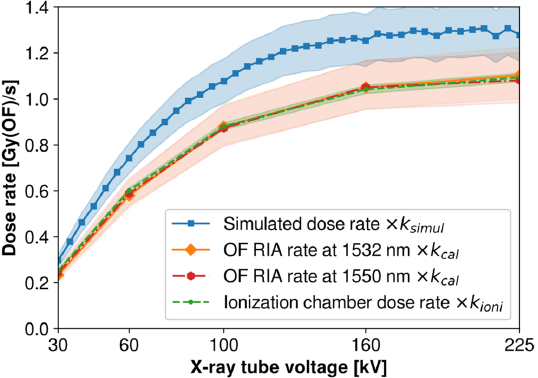
Figure 10. Comparison between dose rate determined by three different means: simulation, scaling of RIA rate and scaling of ionization chamber measurements; for X-ray tube voltages between 30 kV and 225 kV. Filled areas show uncertainties at ±2 σ .